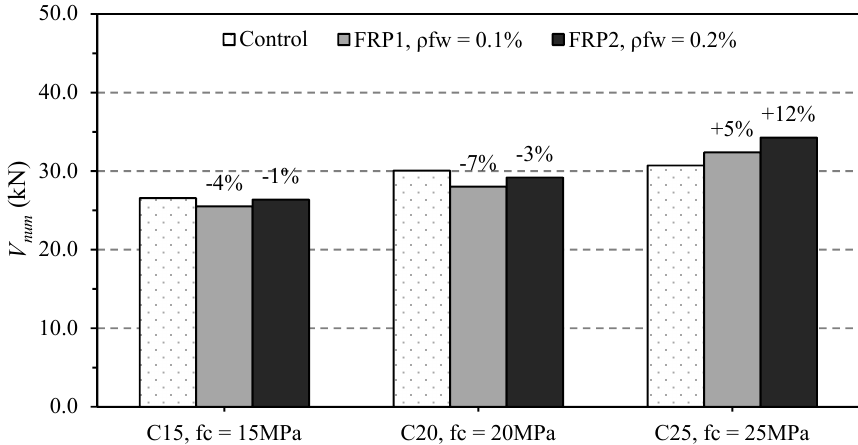
Figure 16. FE analysis on the effect of concrete strength on the shear strength of FRP-strengthened beams (difference to control specimen in %).